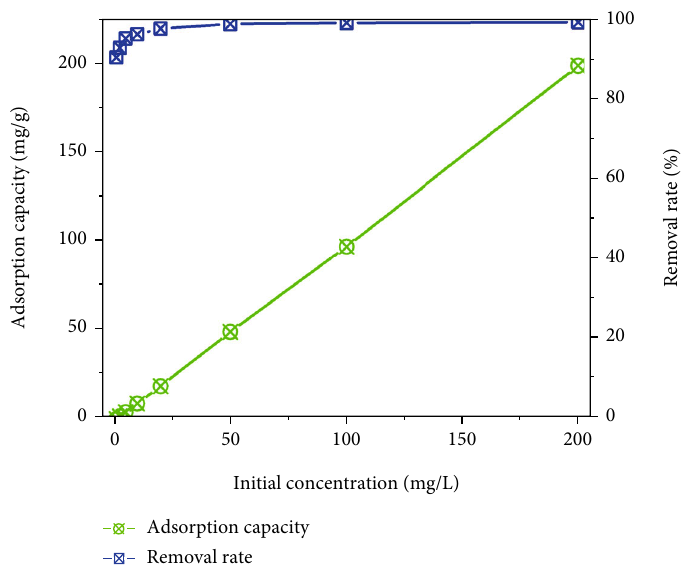
Figure 7: E ff ect of MB concentration on the equilibrium adsorption capacity for P(AANa/AM).